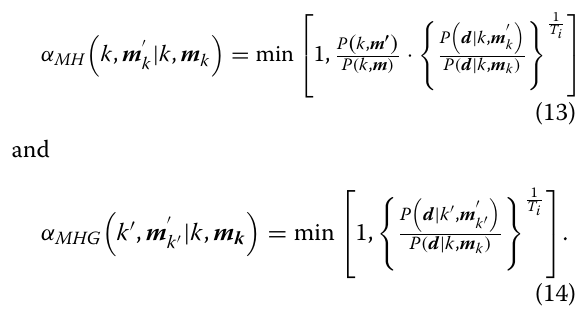
in the time domain and